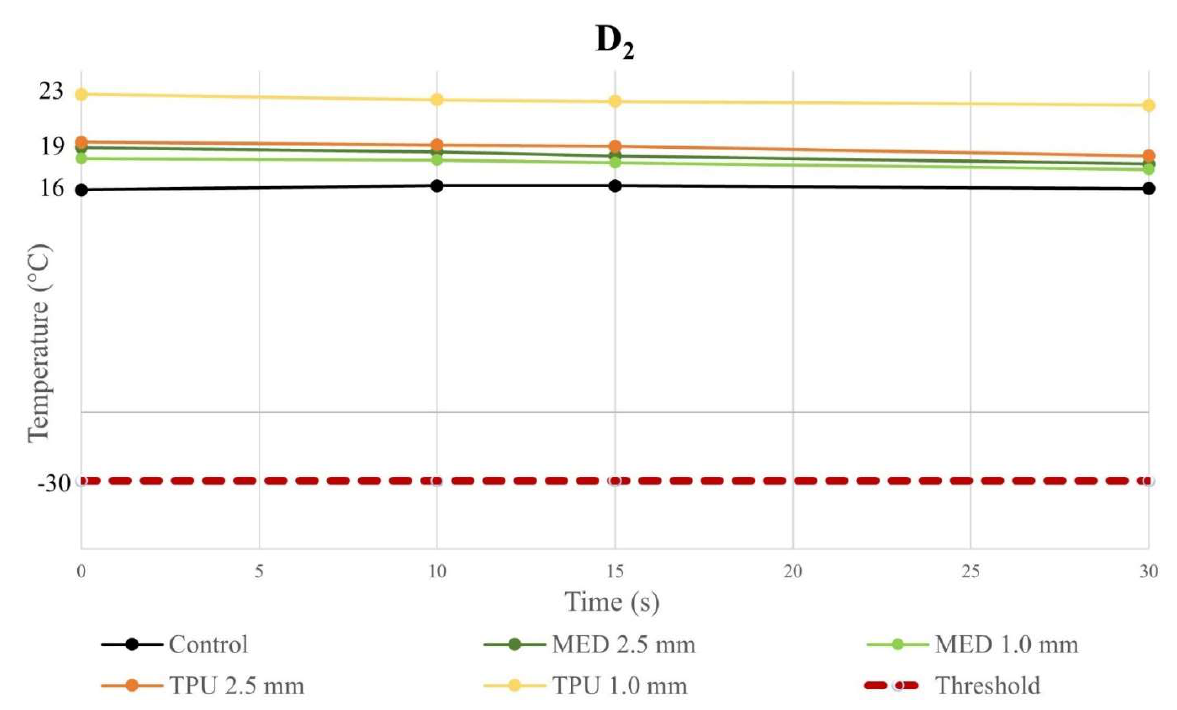
Figure 3. Temperature–time curve of control and biomaterial samples in D 1 . The graph represents the temperature–time curve at D 1 from the cryoablation catheter of the control, MED625FLX and TPU95A of 1.0 and 2.5 mm of thickness; the dashed line indicates the threshold set at −30.0 °C. Below the threshold, the freezing causes cell death.